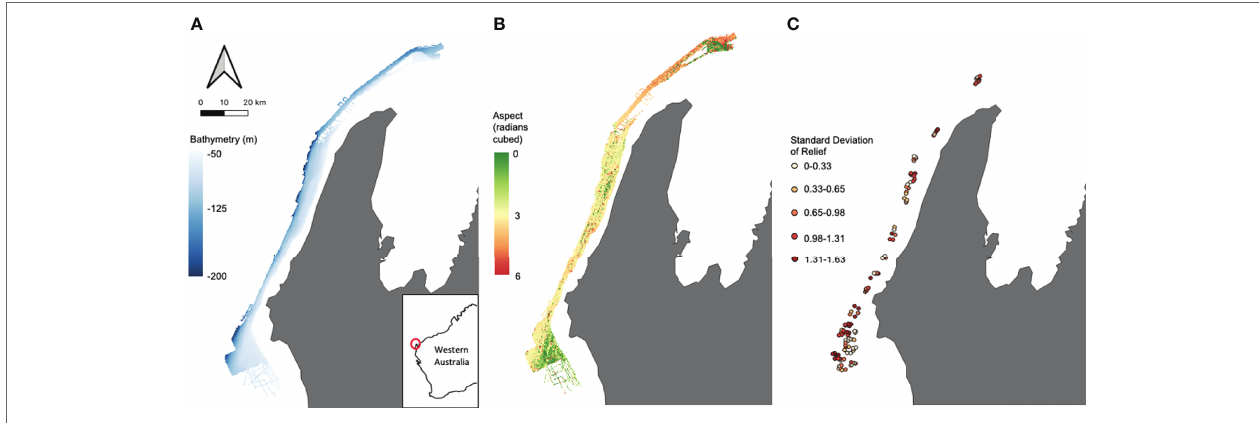
Figure 9 ). No fish measured were more than 7 m from the